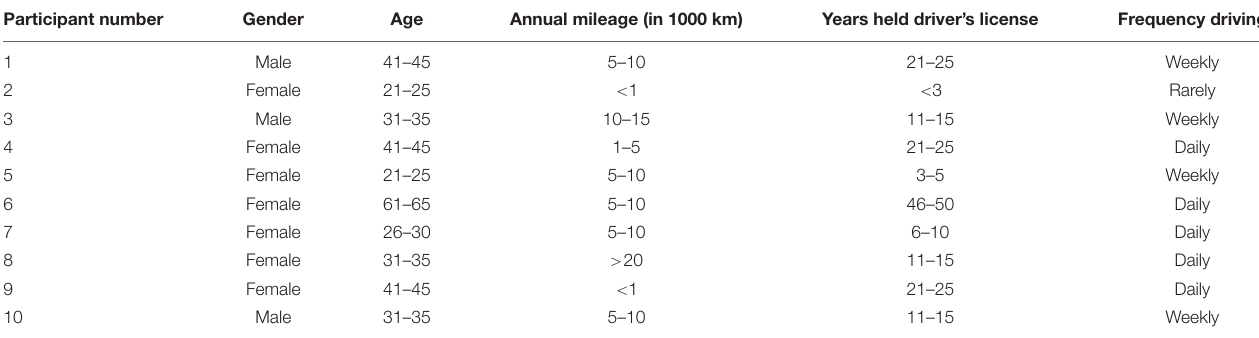
TABLE 1 | Participant demographic lnformation ( n =